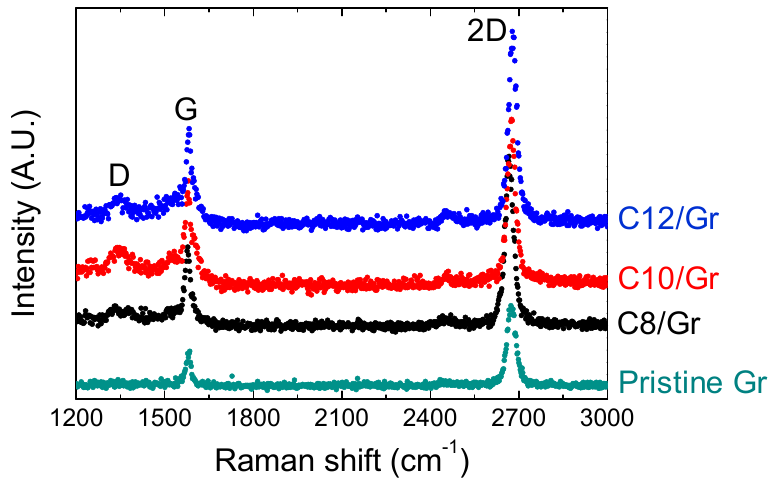
Figure 2. Raman spectra of pristine and arylalkane (C8, C10 and C12)-grafted graphenes transferred to SiO 2 surface.